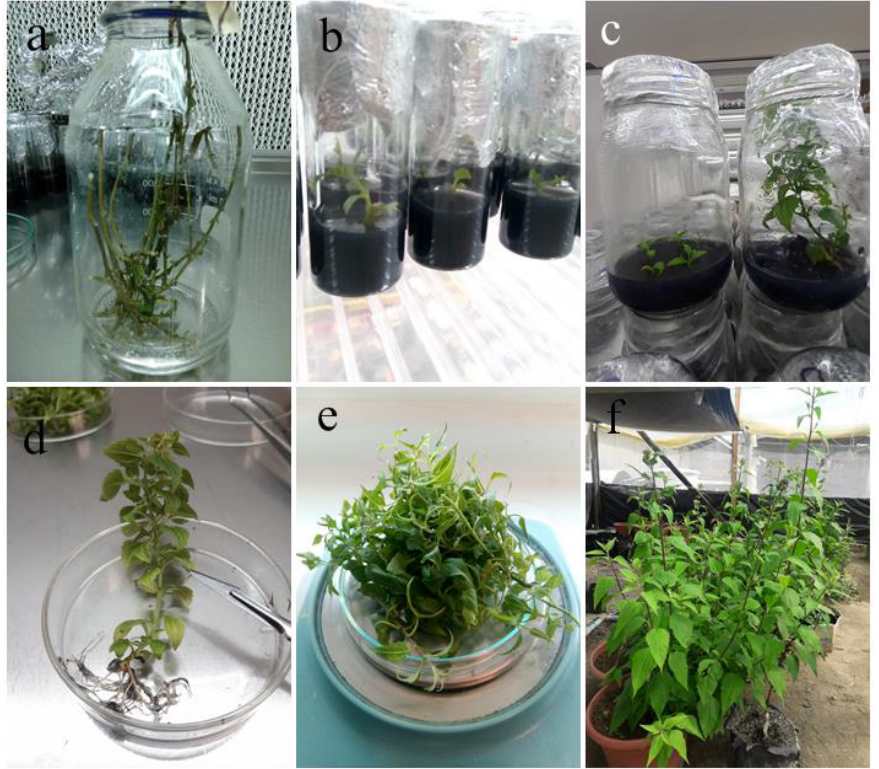
Figure 1. In vitro clonal micro propagation platform of Leptocarpha rivularis . ( a ) Stick with dormant shoot sterilization; ( b ) in vitro culture establishment; ( c ) propagation protocol for in vitro explants; ( d ) complete “adult” plant generated by in vitro culture. Uses for this material will be ( e ) semipolar extraction or ( f ) explant acclimation under greenhouse conditions.